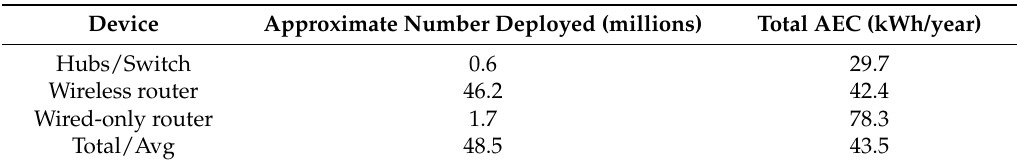
Table 1. Breakdown of energy draw of various networking devices (kWh refers to kilo-Watt hours and AEC refers to Annual Electricity